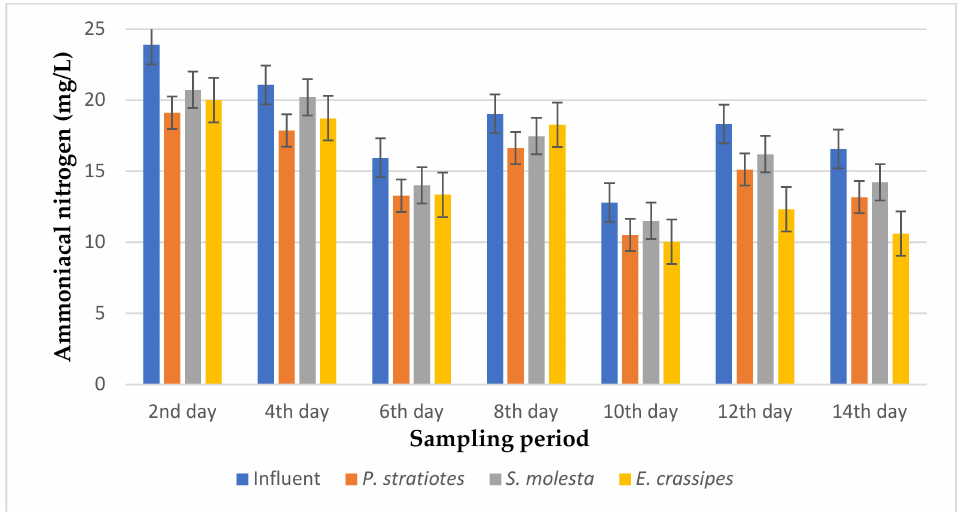
Figure 9. Bar plot of the average ammoniacal nitrogen vs. the sampling period with a 6 h retention